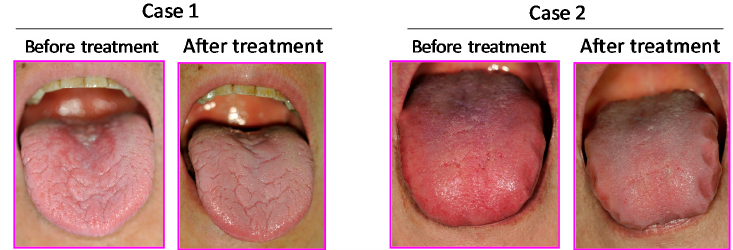
Figure 14. Effect of Byakkokaninjinto on glossitis. Cited from Reference [112] with permission.